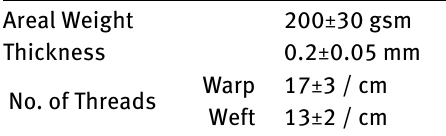
Table 1: Material specifications of fabric